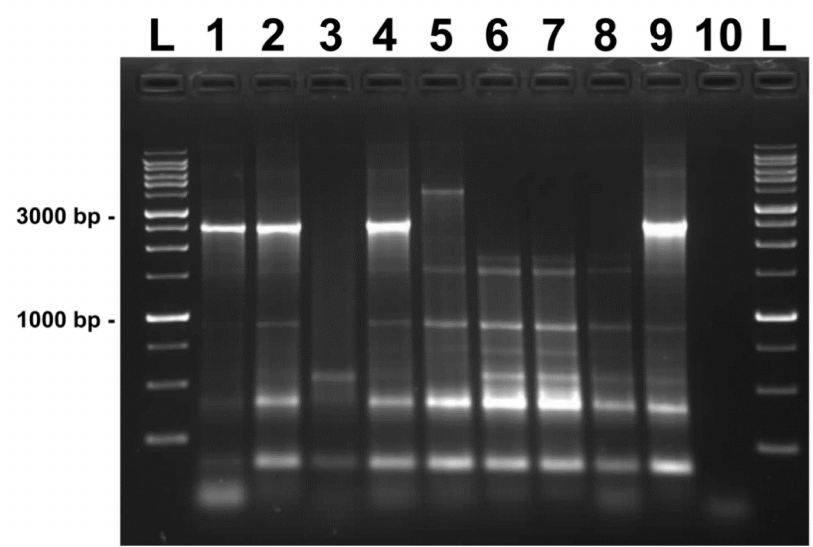
Figure 1. ERIC-PCR fingerprint patterns of P. larvae isolates on 1% agarose gel. Lanes: GeneRuler™ 1 kb DNA Ladder; 1: D3; 2: D4; 3: CCM 38; 4: 5S; 5: 10S; 6: CCM 4484; 7: CCM 4488; 8: CCM 5680; 9: M1; 10: negative control. Size of selected marker bands is shown in base